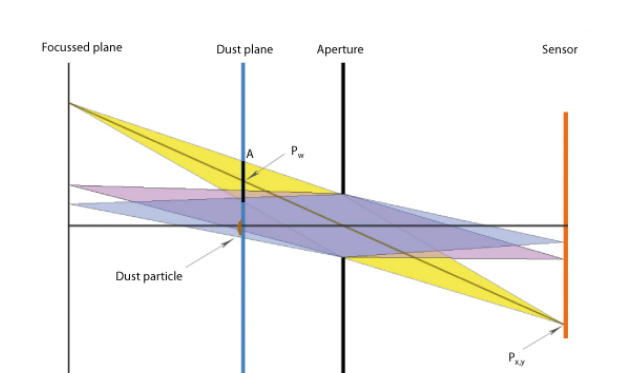
Figure 2 . Camera model of the dust simulation. Notice the parameters A (area of the projected collection cone), p w (in- tersection point of the collection cone with the dust plane and p x , y (pixel position on the sensor)